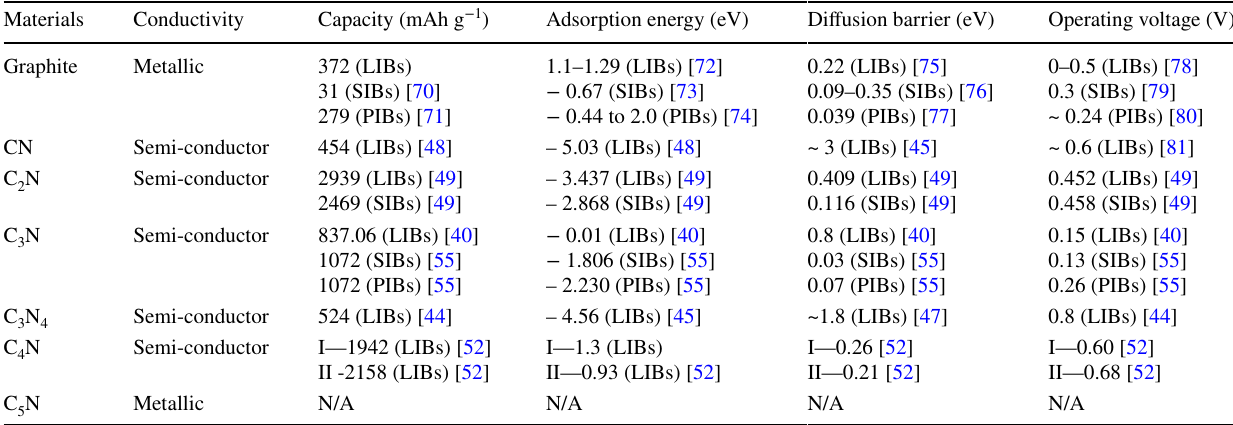
Table 1 Comparison of the DFT predicted parameters of pure carbon nitrides with commercial graphite for energy storage devices Materials